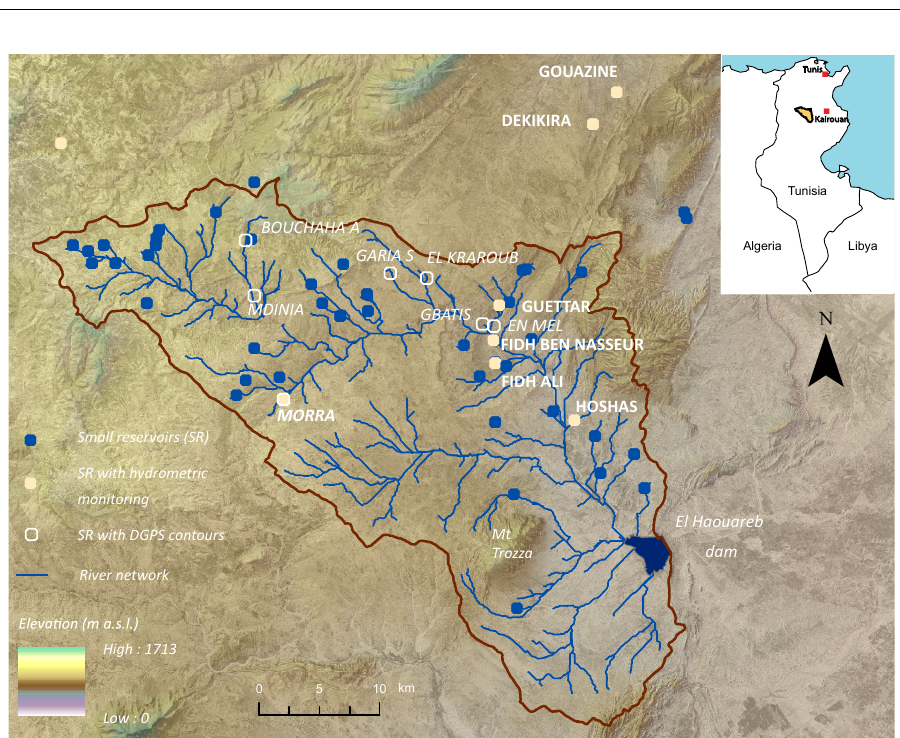
Figure 1. Merguellil upper catchment and location of instrumented small